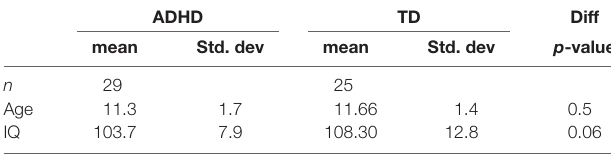
TABLE 1 | Demographics of the population. ADHD TD